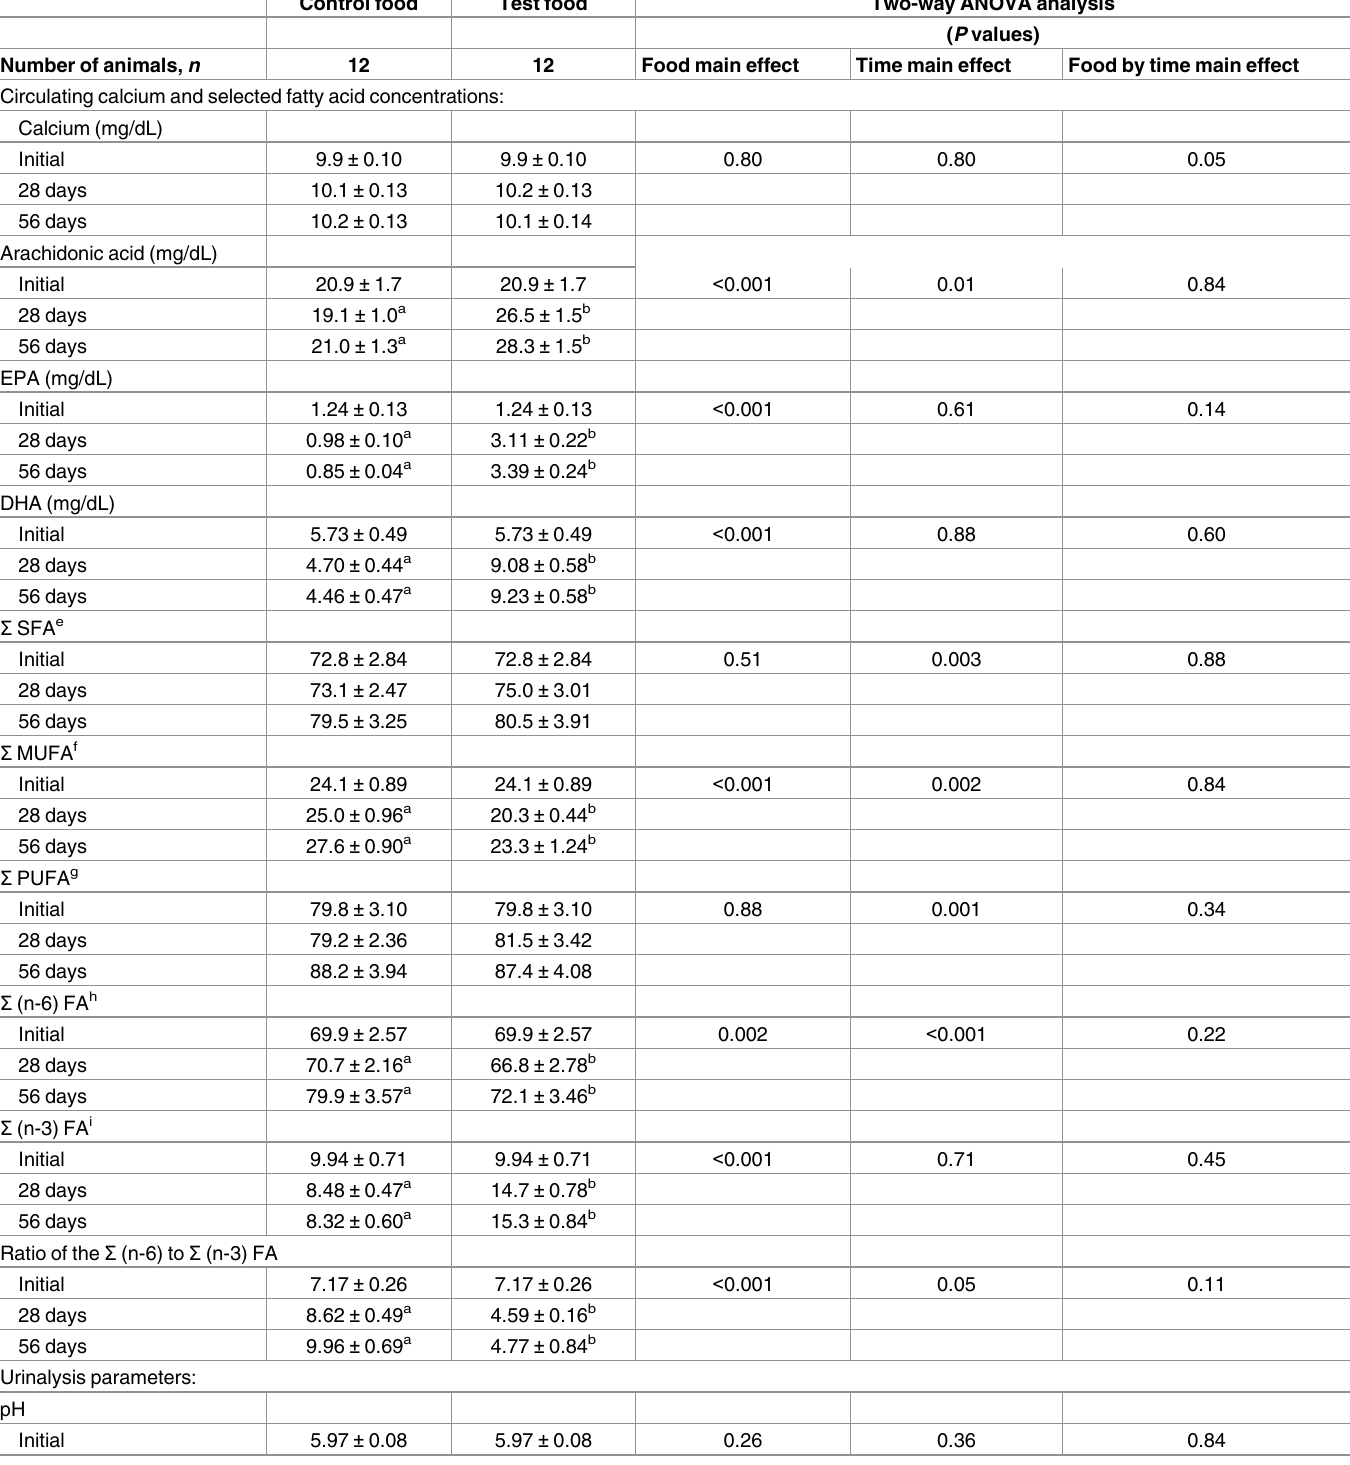
Table 2. Circulating concentrations of blood analytes and urinalysis parameters (mean ± SEM) of cats at baseline (initial) and after consuming control or test food for 28 and 56 days. Control food Test food Two-way ANOVA analysis